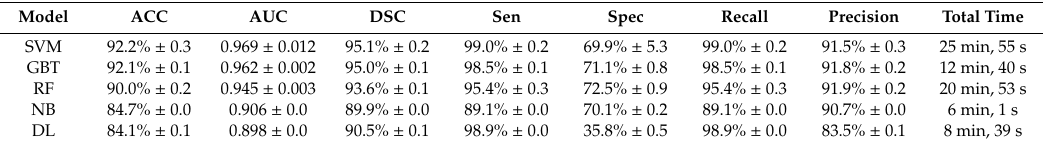
Table 4. Ten-fold cross-validation performance evaluation.